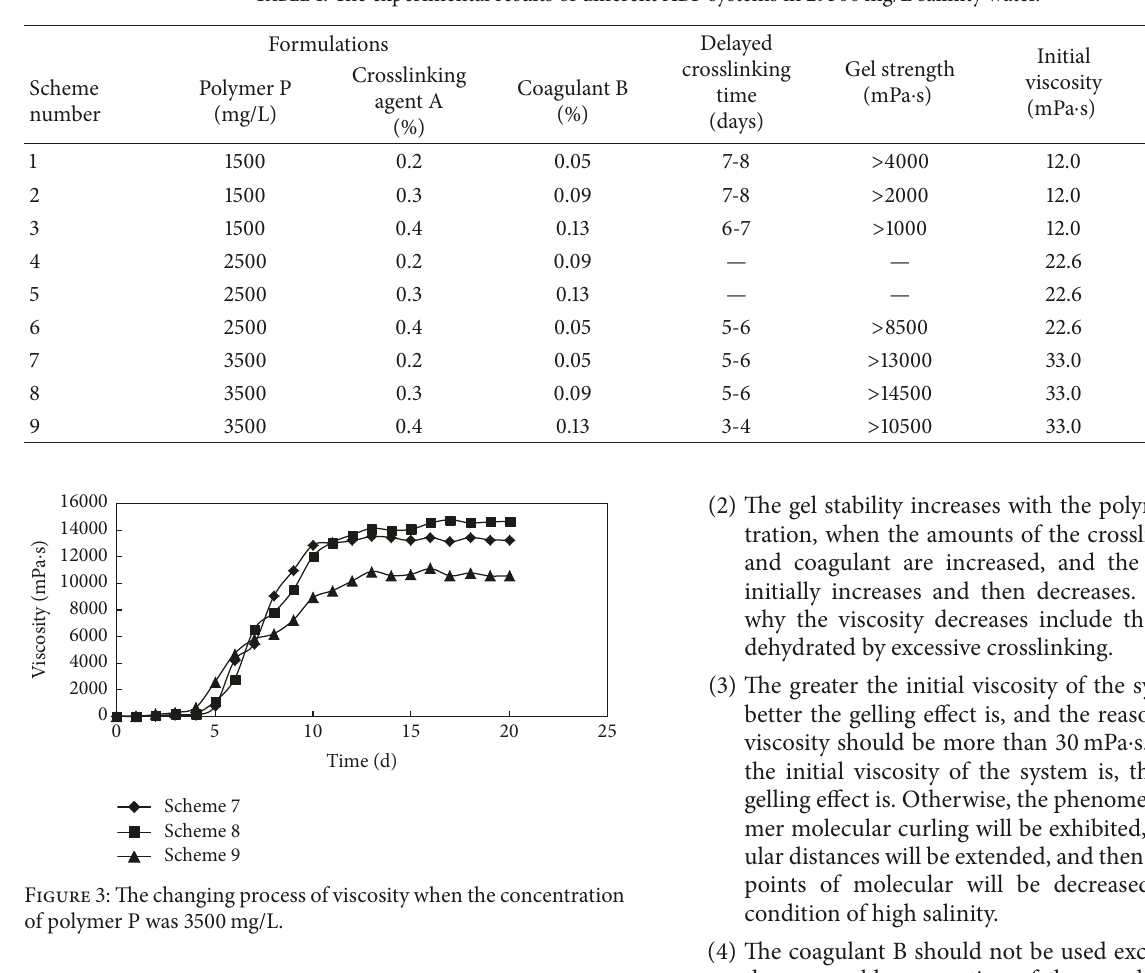
Table 1: The experimental results of different ABP systems in 29500 mg/L salinity water.